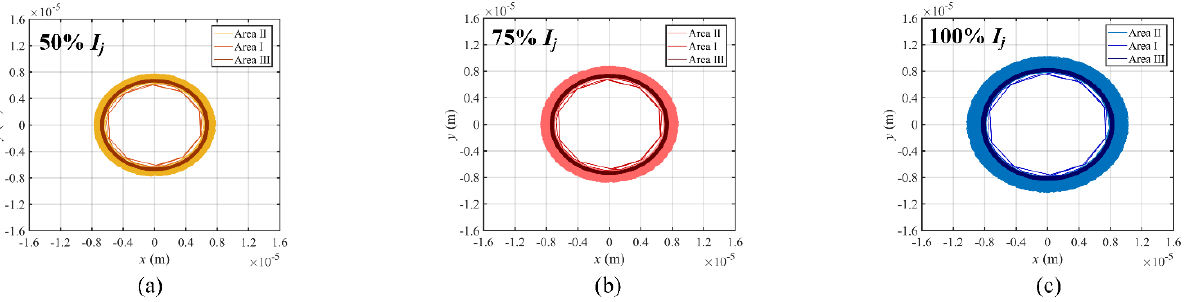
Figure 19. The axis trajectory of the generator rotor under different excitation currents. ( a ) 50% I j ; ( b ) 75% I j ; ( c ) 100% I j .